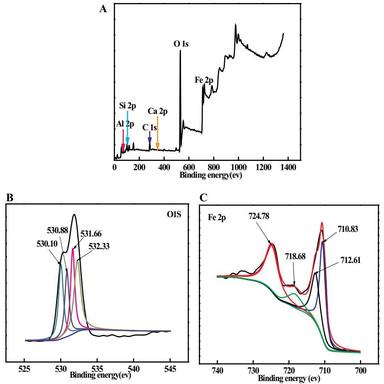
XPS photoelectron spectroscopy of Fe3O4/rectorite (A), high-resolution XPS spectra of O1s (B) and Fe2p (C).